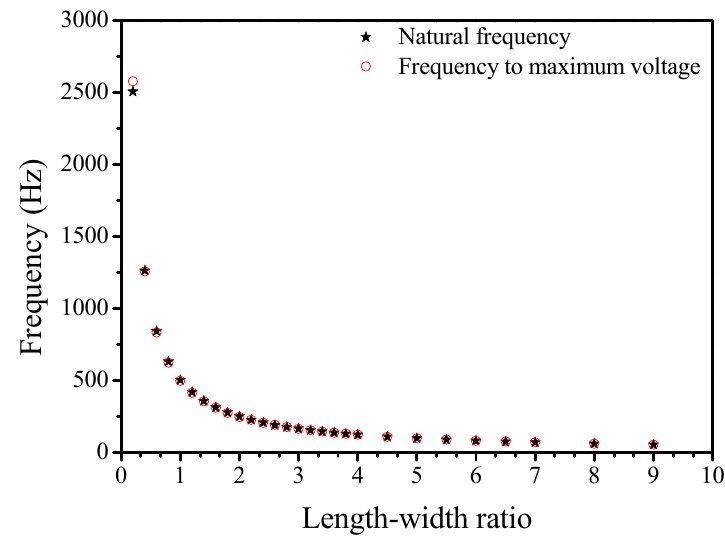
Figure 9. Length-width ratio versus natural frequency of PCP and exciting frequency at maximum voltage in cantilever beam fixation mode.